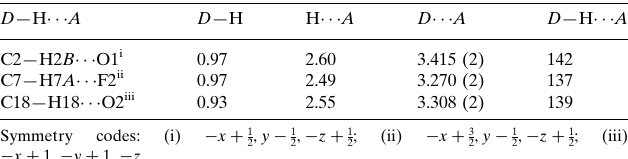
Hydrogen-bond geometry (A˚ , (cid:3)